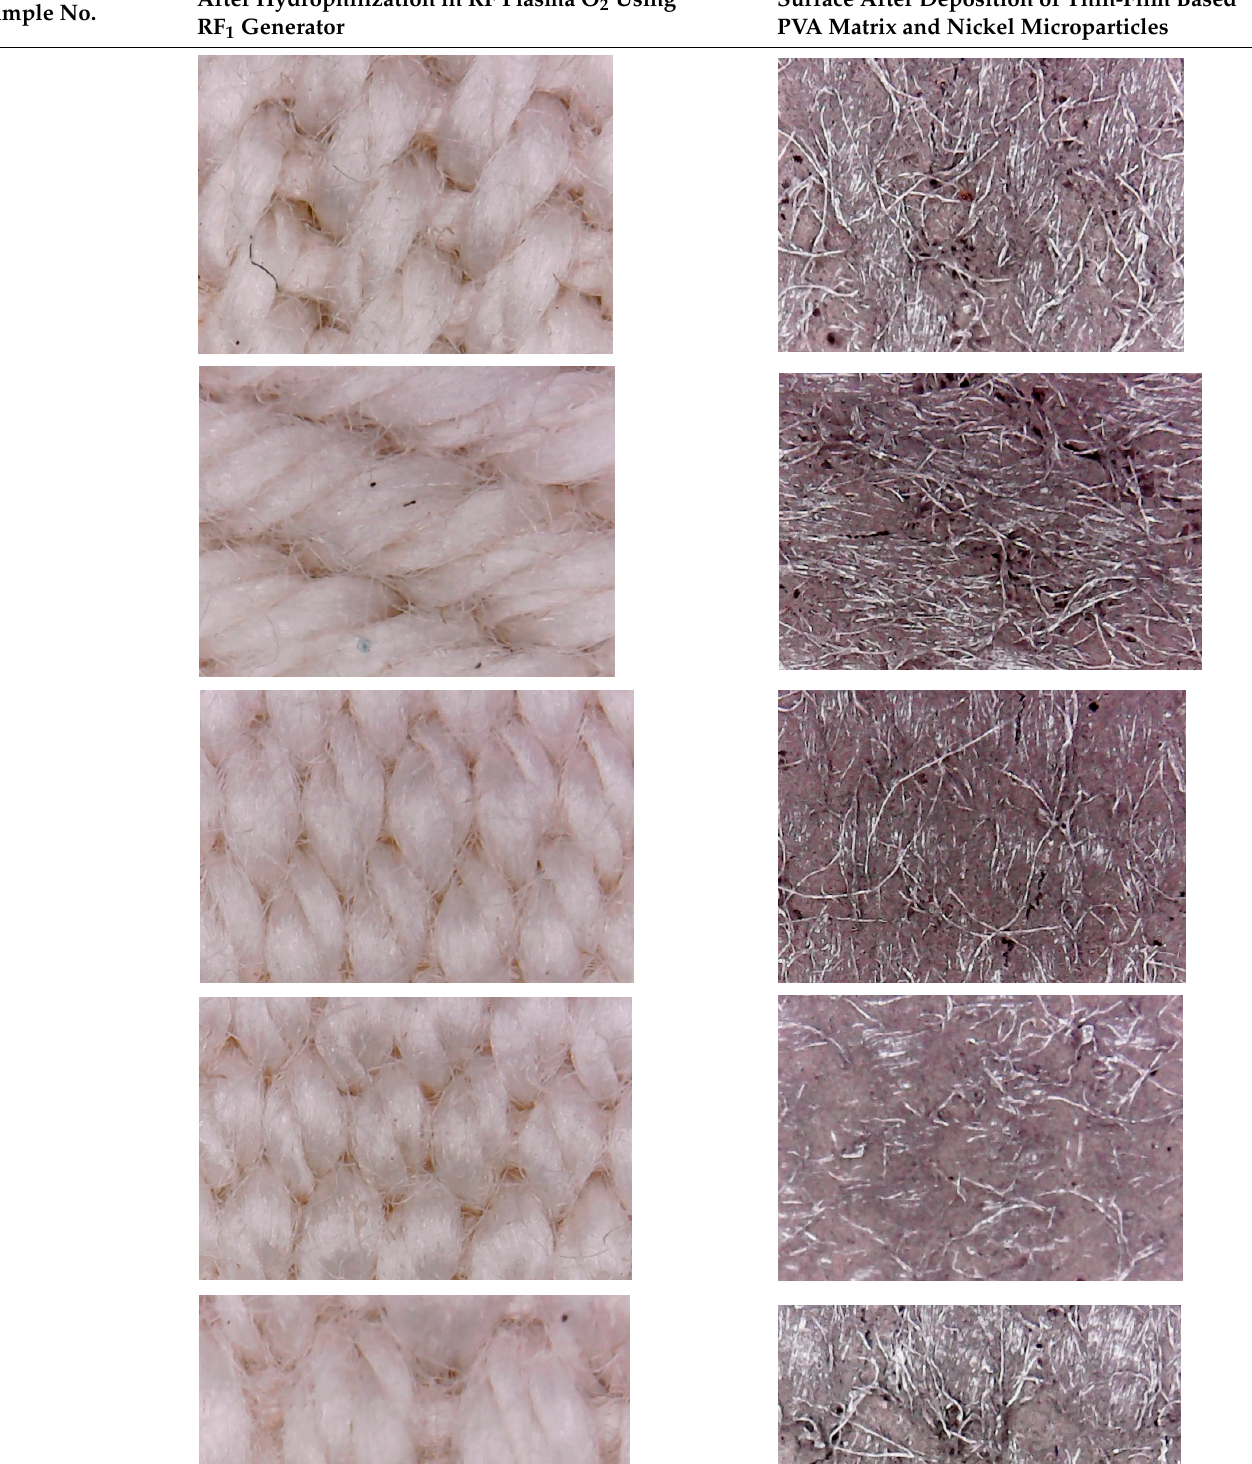
Table 3. Surface topography of the textiles functionalized in RF plasma O 2 using RF 1 generator. Sample No.